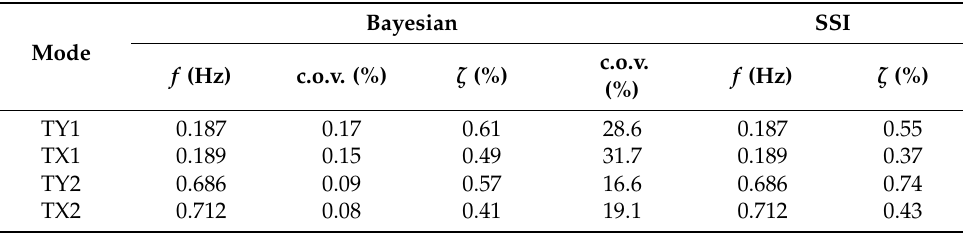
Table 1. Modal parameters identified via the Bayesian approach and